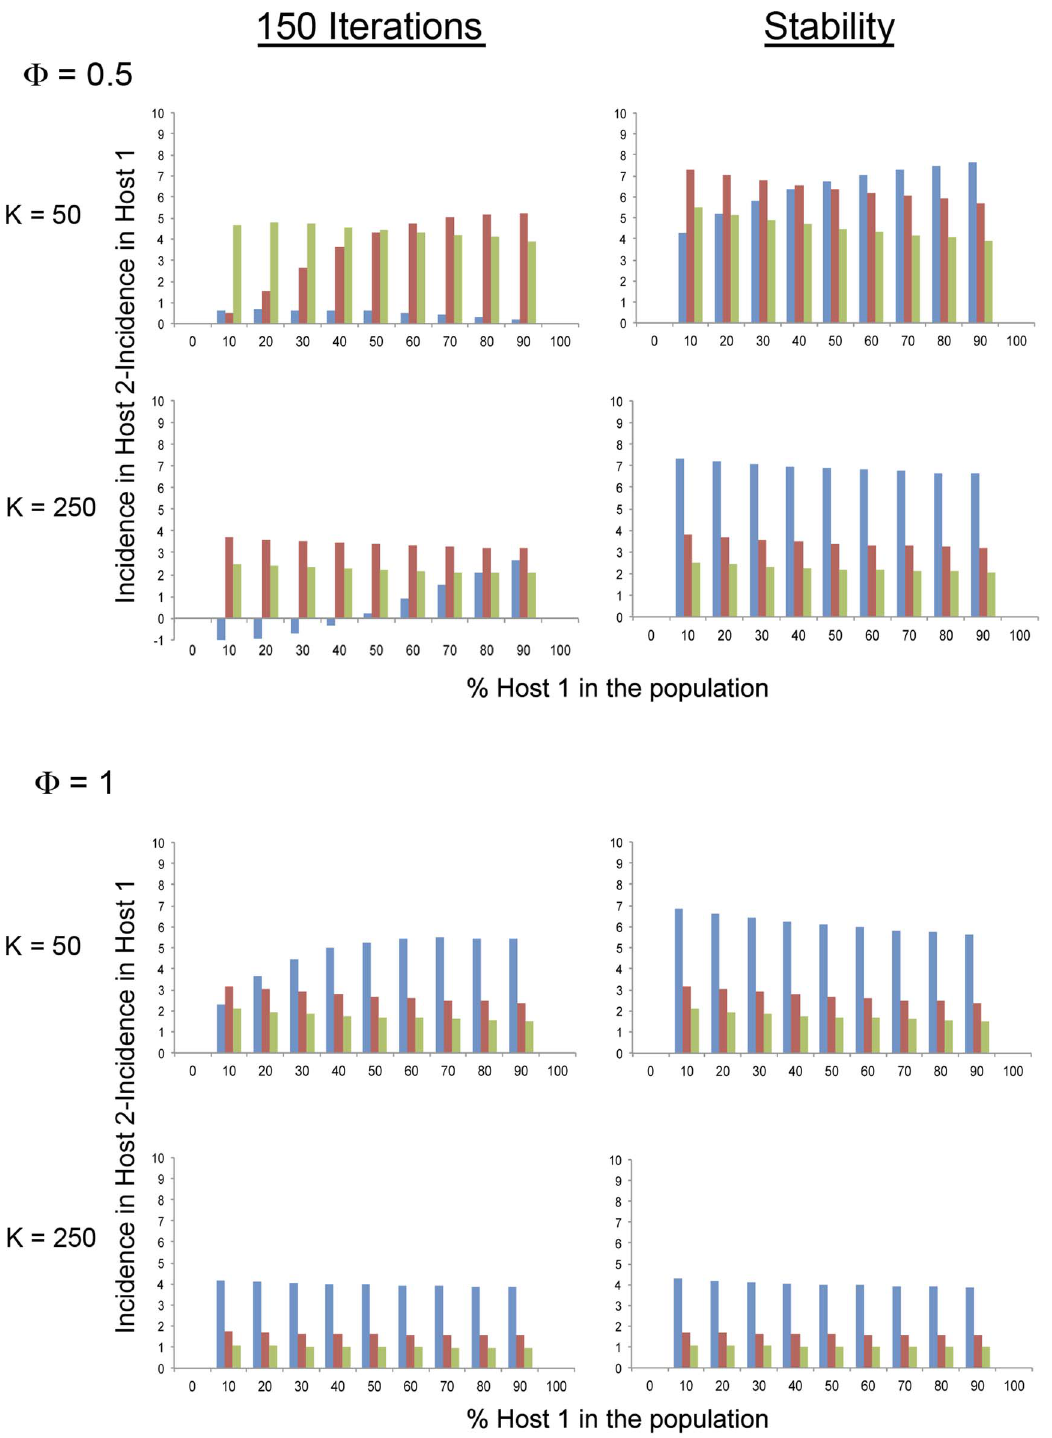
Figure 2. Model simulation values of the variation of the difference between CMV incidence in a long-lived (Host 2) and a short- lived (Host 1) Arabidopsis genotype, within a heterogeneous population according to the relative frequency of each genotype in the population. Data are presented for two different host plant population densities ( K , plants 6 m 2 2 ), three different aphid densities ( Q , aphids 6 plant 2 1 , Q =1 in blue, Q =3 in red, Q =5 in green) and two different rates of visit per aphids ( W , visits 6 day 2 1 ), both after 150 iterations of the model and at equilibrium.